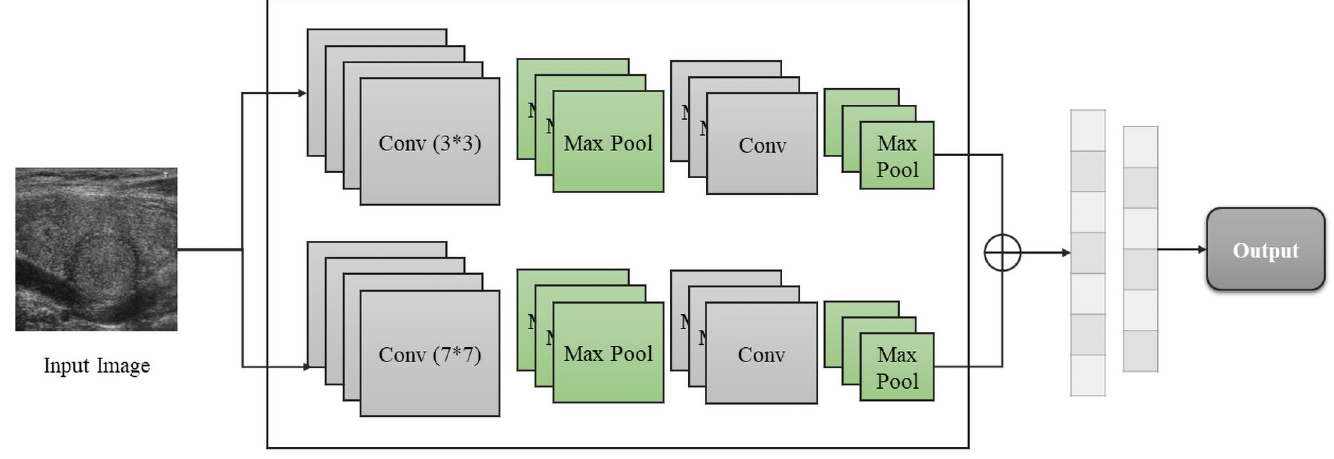
Fig 3. Single input dual-channel